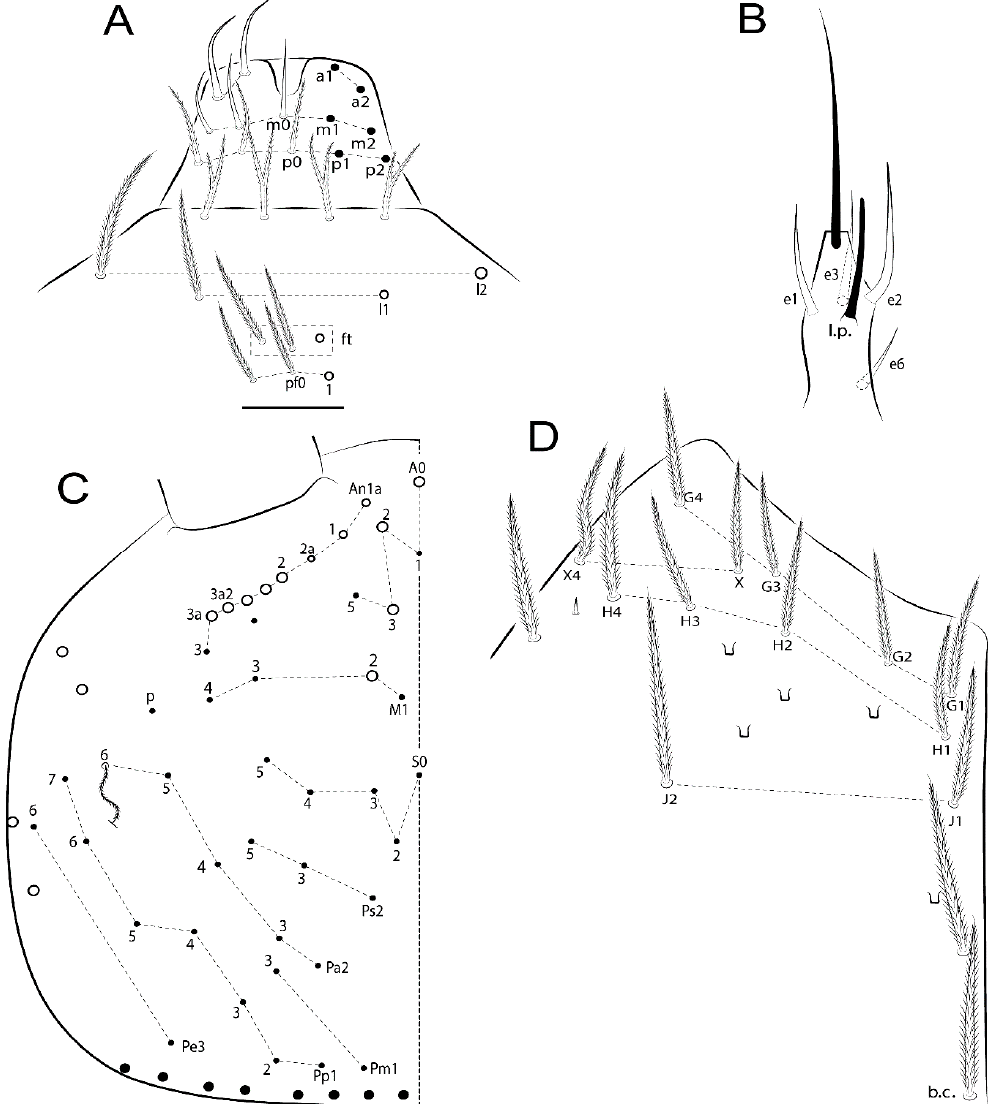
Figure 64. Pseudosinella ambigua : head. ( A ) chaetotaxy of clypeus, prelabrum, and labrum; ( B ) labial papilla E (right side); ( C ) head dorsal chaetotaxy (left side); ( D ) postlabial chaetotaxy (left side).